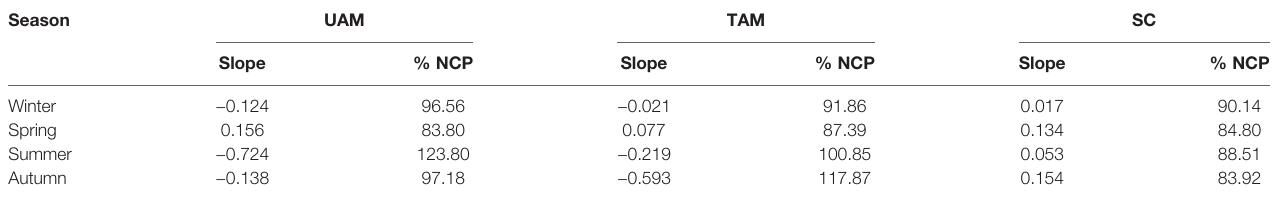
TABLE 3 | The slope of the salinity normalized total alkalinity ( nA T ) – salinity normalized total inorganic carbon ( nC T ) vector and the relative percent in fl uence of net community production (%NCP) on changes in nC T at three habitat sites (UAM, ulvoid algal mat; TAM, turf algal mat; SC, coexisting Sargassum horneri and crustose coralline algae) in four